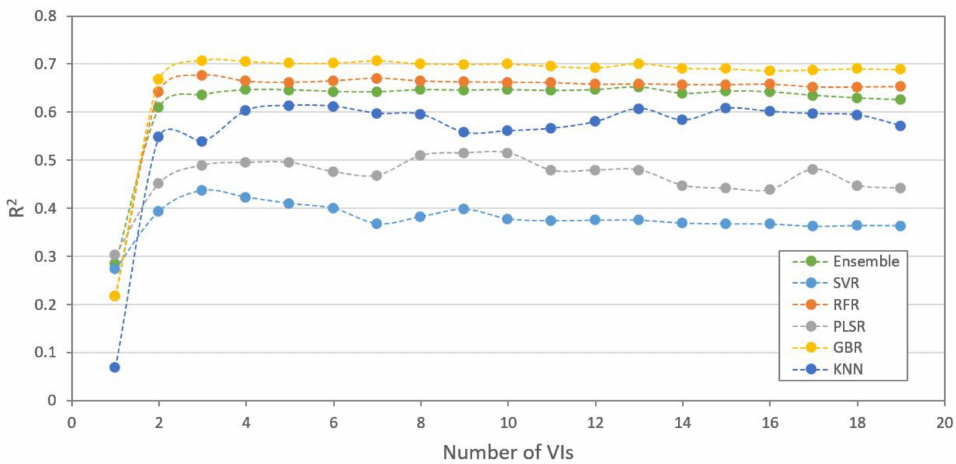
Figure A3. Model training accuracies as a function of the number of VIs derived from 0.045 m GSD RGB